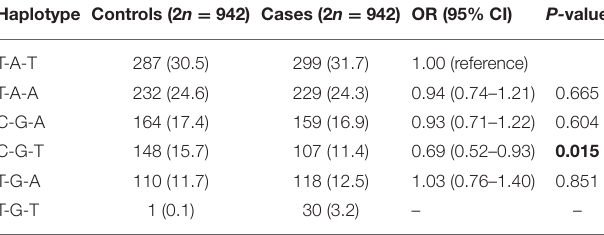
TABLE 4 | Haplotype analysis of rs11730582-rs2853750-rs35893069 with the BRC